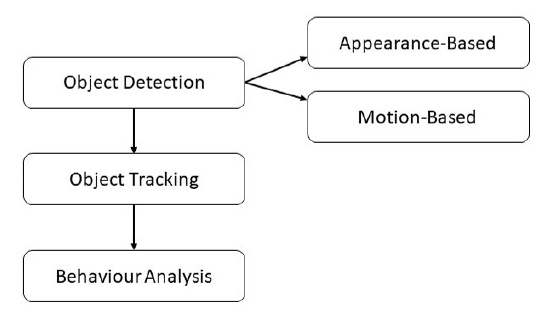
Figure 1. Three stages of camera-based vehicle